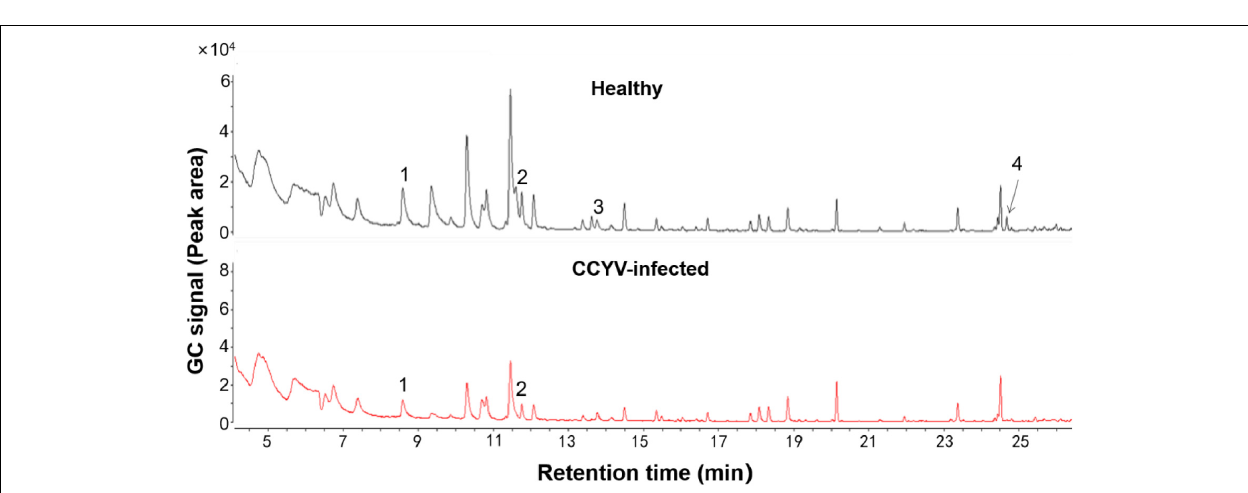
FIGURE 4 | Gas chromatography profiles of headspace volatiles from healthy and CCYV-infected Cucumis sativus seedlings. 1: α -pinene, 2: β -ocimene, 3: nonanal, and 4: α -farnesene.